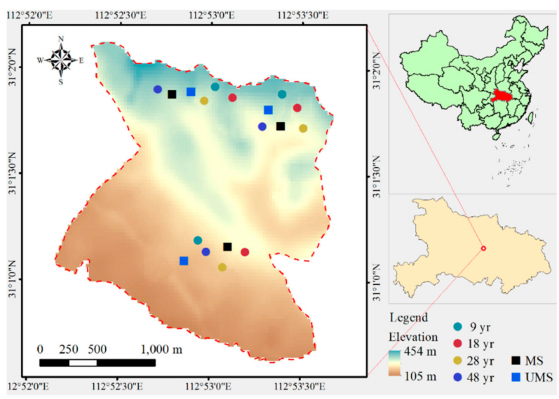
Figure 1. Map of the study area showing stand age and management classes in the Taizishan Forestry Administration Bureau, Hubei Province,